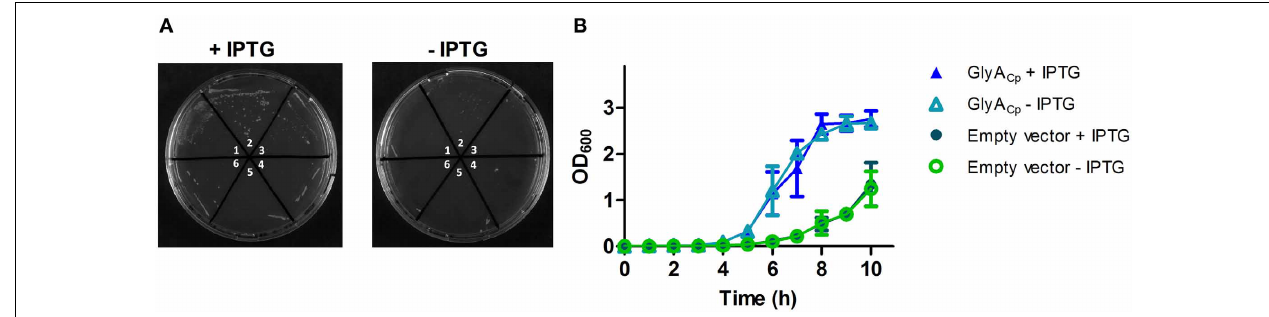
FIGURE 2 | GlyA Cp exhibits in vivo activity in an E. coli racemase double mutant. A temperature sensitive (cid:2) alr (cid:2) dadX E. coli double mutant was transformed with pET21b- glyA Cp to allow for the expression of GlyA Cp in the cytoplasm. Independently generated transformants (1–3 containing pET21b- glyA Cp and 4–6 containing the